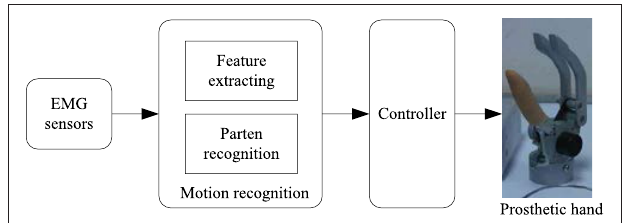
FIGURE 1 | A typical control mode of the EMG prosthetic